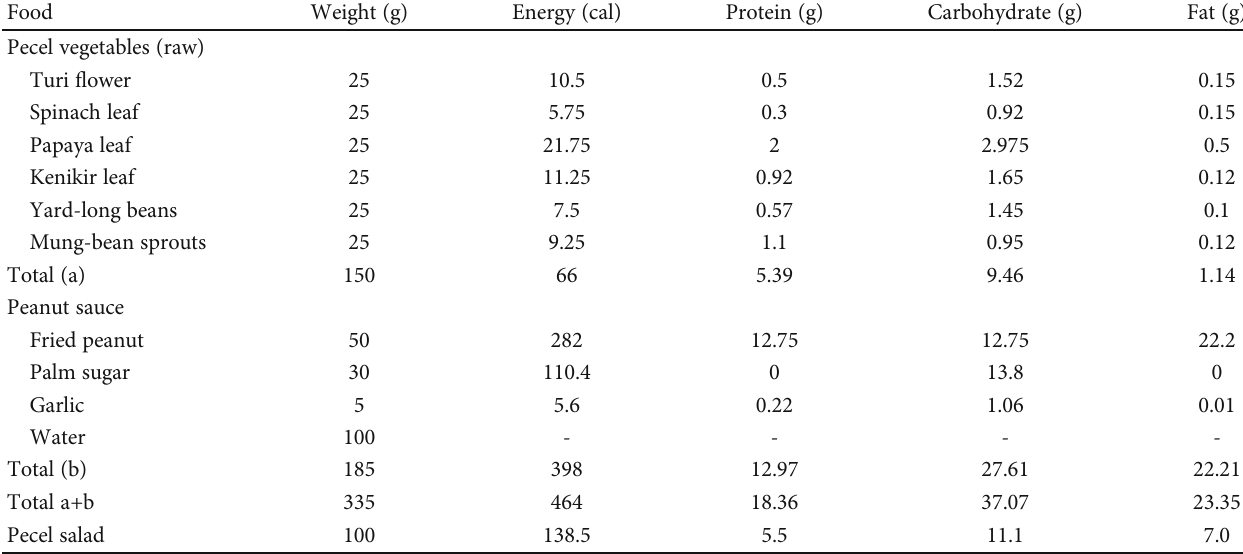
Table 5: Nutrition content of Pecel vegetables based on the database of Indonesian Food Composition List (DKBM) (INA) ∗ . Food Weight (g) Energy (cal) Protein (g) Carbohydrate (g) Pecel vegetables (raw) Turi fl ower Spinach leaf Papaya leaf Kenikir leaf Yard-long